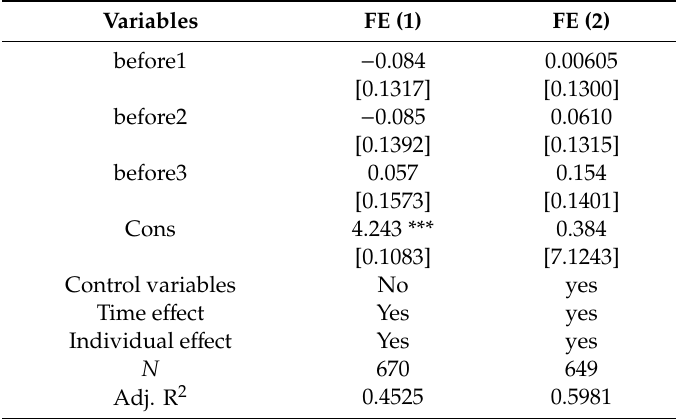
Table 9. Test of the common trend assumption, using a counterfactual test.